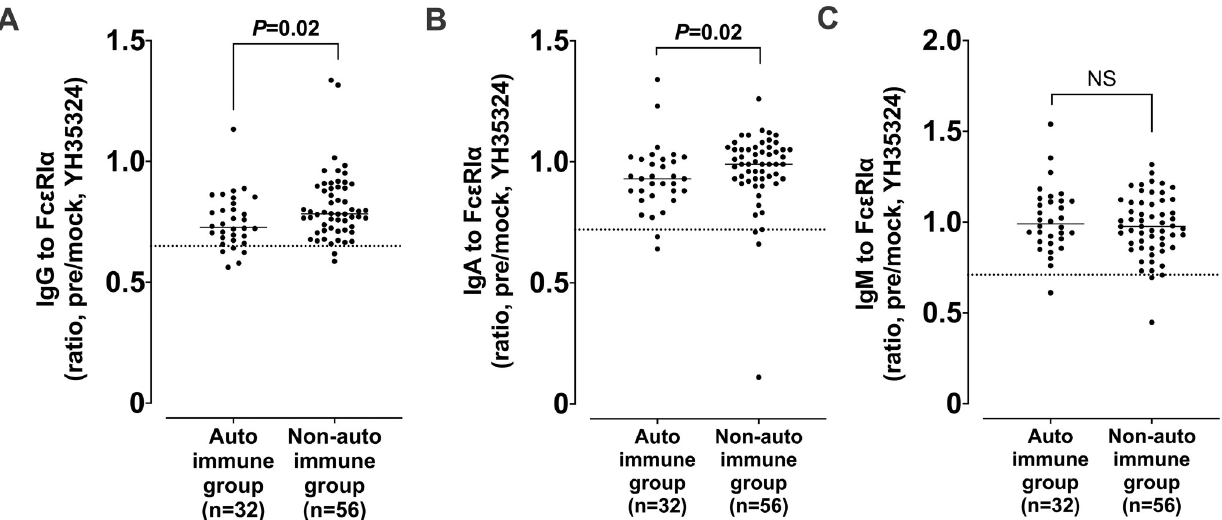
Fig 2. Comparisons of serum IgG/IgA/IgM levels to Fc ε RI α between the autoimmune and nonautoimmune groups. The results were presented by the IgG ratio of YH35324-pretreated to mock-treated value (A), the IgA ratio of YH35324-pretreated to mock-treated value (B) and the IgM ratio of YH35324-pretreated to mock-treated value (C). The autoimmune group was defined if CSU patients have a positive result to ASST or ANA test. Horizontal lines and dotted lines show median values and cutoff values of each autoantibody Fc ε RI α respectively. P value was evaluated by Mann-Whitney test. ASST, autologous serum skin test; ANA, antinuclear antibody; NS, no statistical significance.